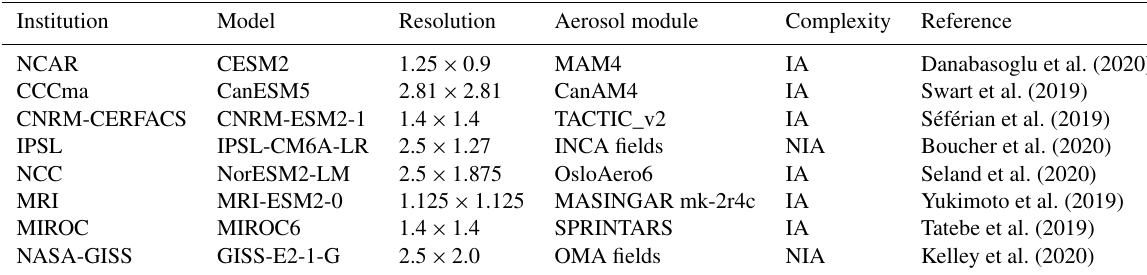
Table A2. Details on the models used. IA: interactive aerosols. NIA: non-interactive aerosols.